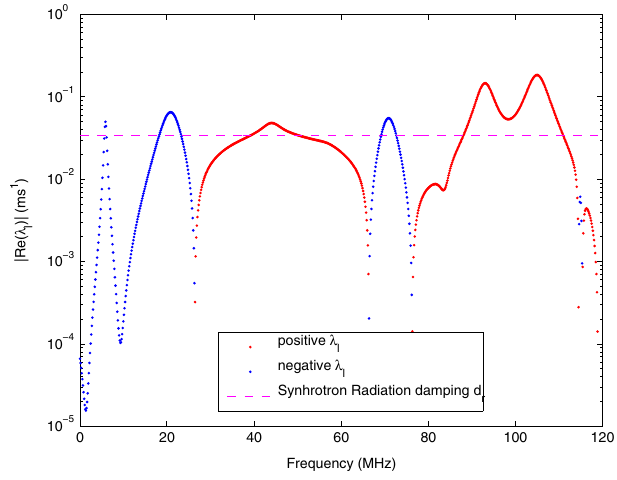
FIG. 1. (Color) Growth rate estimates from impedance measure- ments for 3 A LER. Impedance data from [3], growth rate estimates from [4].